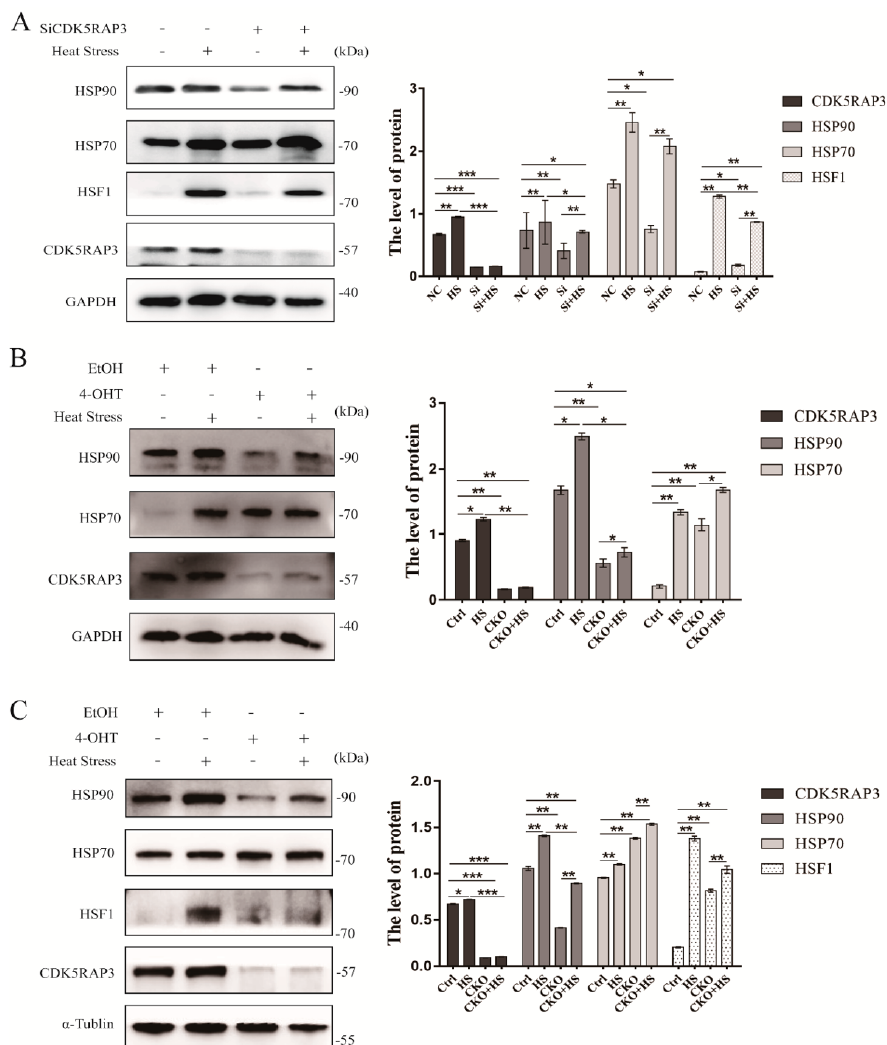
Figure 3. CDK5RAP3 deletion inhibited the expression of HSP90, while HSP70 showed no significant change. Protein accumulation of HSP70 and HSP90 in bovine mammary epithelial cells ( A ), mouse fibroblasts ( B ) and mammary gland of mice ( C ) cultured under heat stress (42 °C 3 h) and corresponding control (37 °C). The BMECs were silenced by using the SiRNA of CDK5RAP3, marked as ‘+’. Tamoxifen(4-OHT) were injected to knock out the CDK5RAP3 gene in mouse fibroblasts cells, marked as ‘+’. The method of obtaining and CDK5RAP3 F/F : CAG-Cre ERT2 mice were detailed in the